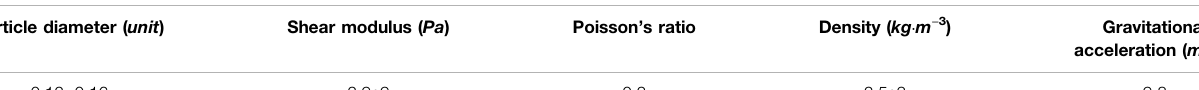
TABLE 2 | Parameters of particles in the discrete element models.